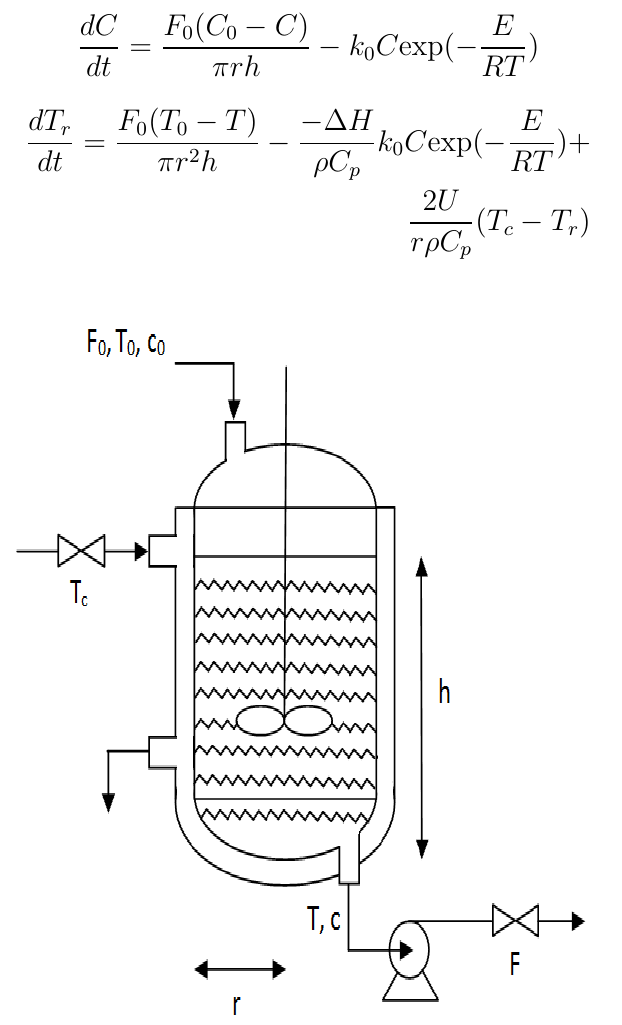
Figure 3. Schematic representation of the continuous stirred-tank reactor